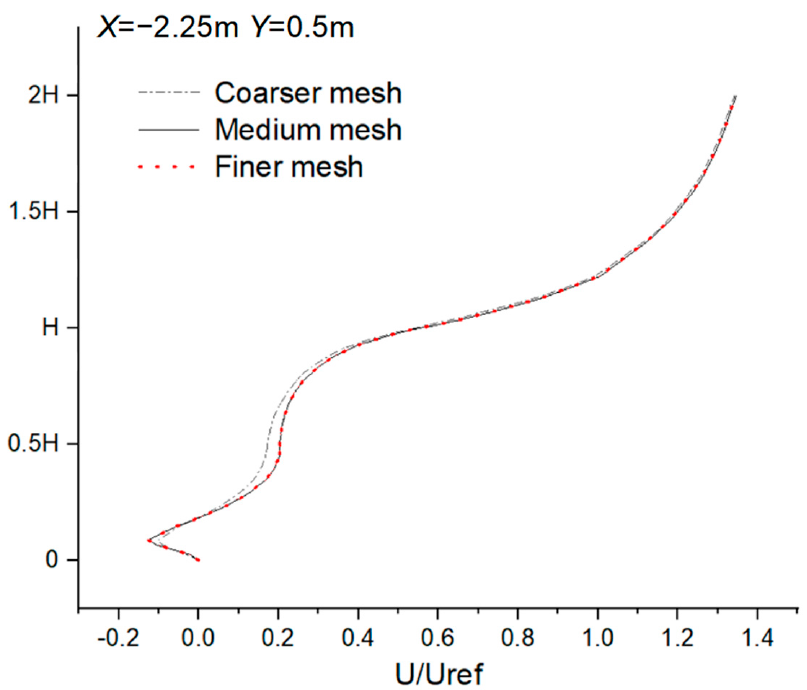
Figure 6. Comparison of mean velocity profiles using three types of mesh systems at the vertical line of X = − 2.25 m, Y = 0.5 m.